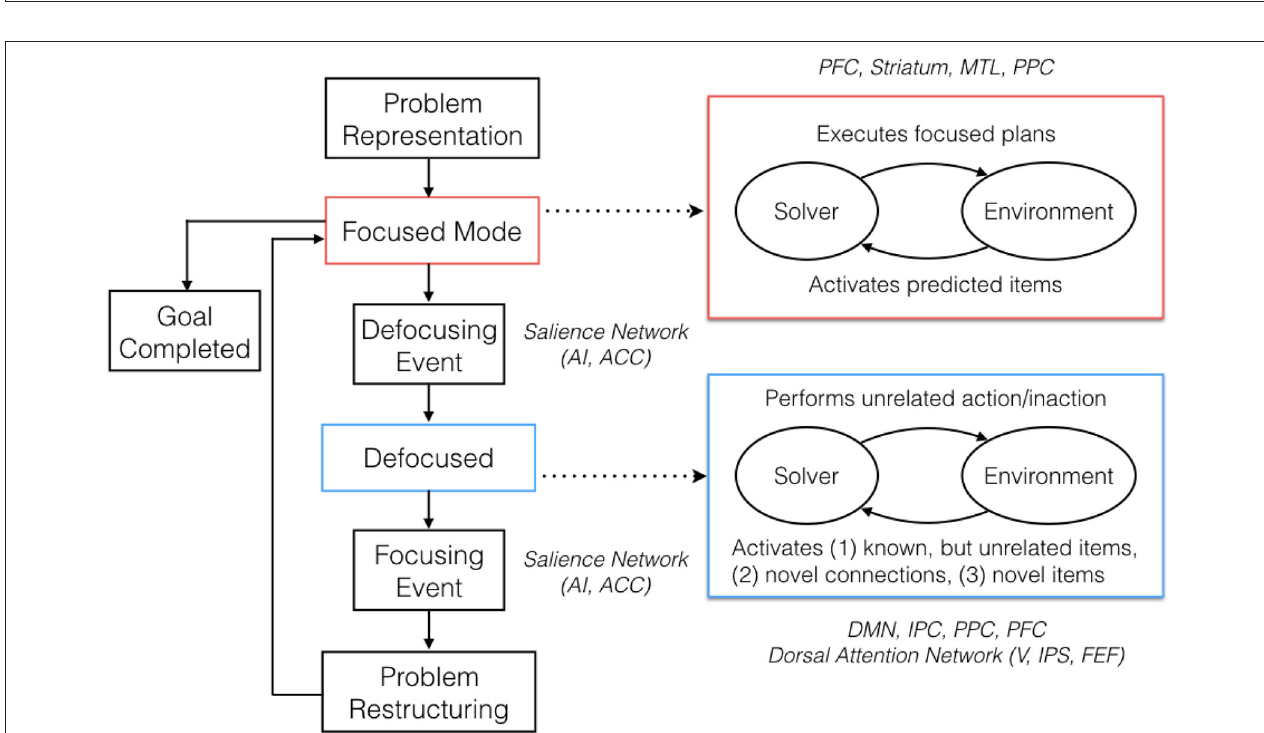
FIGURE 2 | Proposed Model for Real World Problem Solving (RWPS). The corresponding neural correlates are shown in italics. During problem-solving, an initial problem representation is formed based on prior knowledge and available perceptual information. The problem-solving then proceeds in a focused, goal-directed mode until the goal is achieved or a defocusing event (e.g., impasse or distraction) occurs. During focused mode operation, the solver interacts with the environment in directed manner, executing focused plans, and allowing for predicted items to be activated by the environment. When a defocusing event occurs, the problem-solving then switches into a defocused mode until a focusing event (e.g., discovery) occurs. In defocused mode, the solver performs actions unrelated to the problem (or is inactive) and is receptive to a set of environmental triggers that activate novel aspects using the three mechanisms discussed in this paper. When a focusing event occurs, the diffused problem elements cohere into a restructured representation and problem-solving returns into a focused mode.